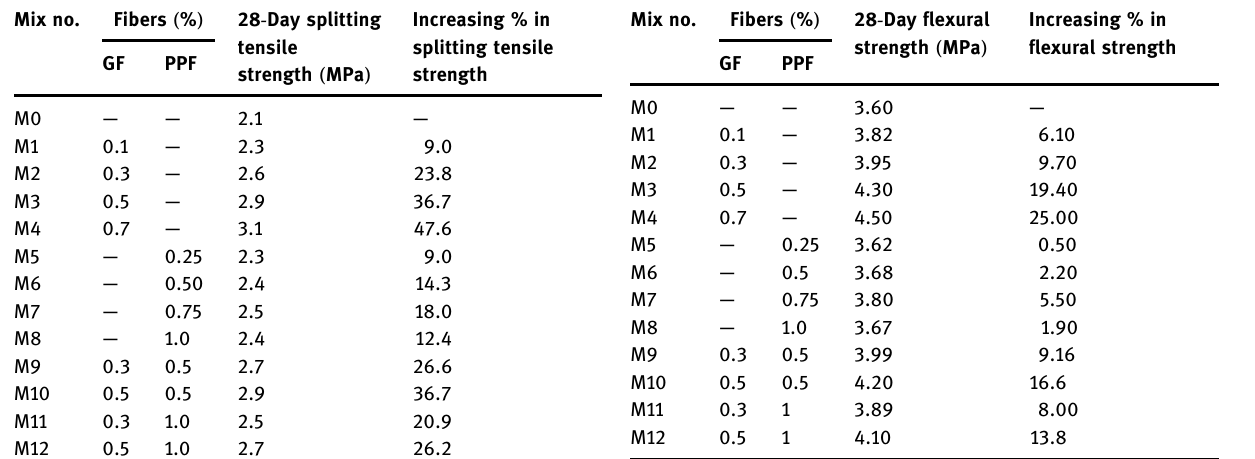
Table 15: Flexural strength test results of LWC mixes